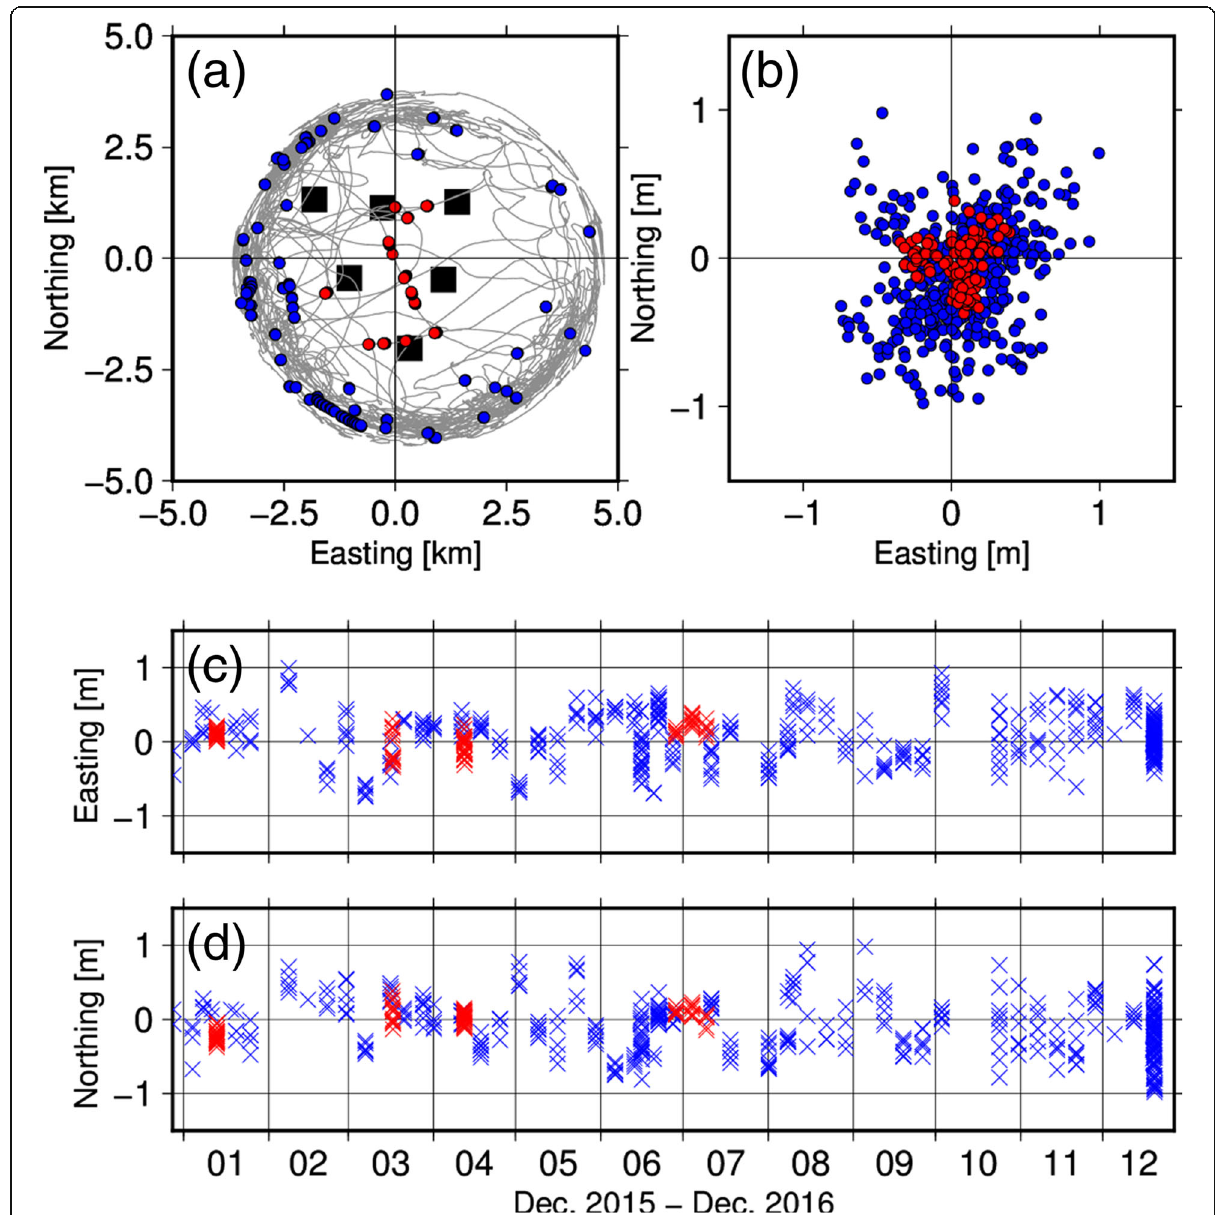
Fig. 4 Track of the buoy and the results of array positioning using the buoy-based observation data a Track of the moored buoy (a gray line) during continuous observation in 2016. The buoy positions during GNSS-A measurement are represented by red or blue circles, classified according to the position inside or outside the array, respectively. The circles and crosses in Fig. 4b – d show estimated array positions relative to the array center for each ping when all six PXPs responded. b Map view in horizontal direction, c time series of EW component, and d time series of NS component of estimated array